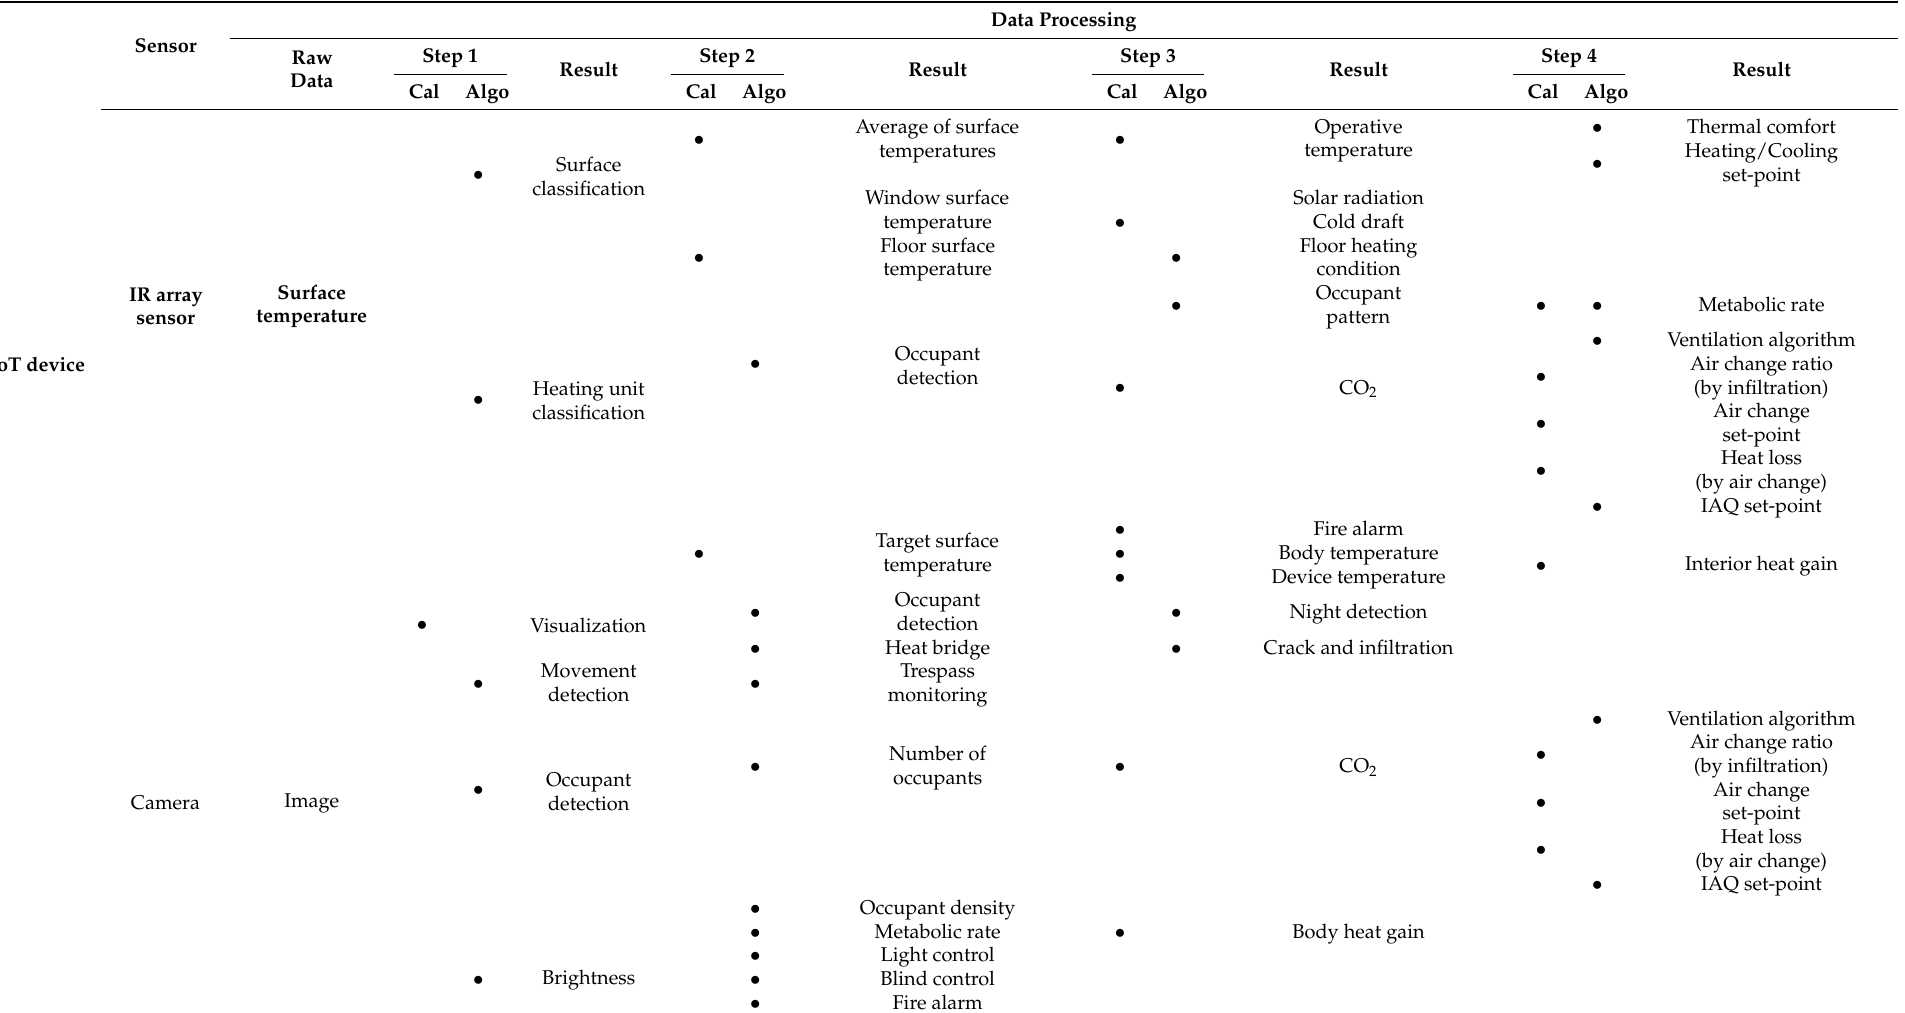
Table 9. Variety of purposes using the IoT device with camera and IR array